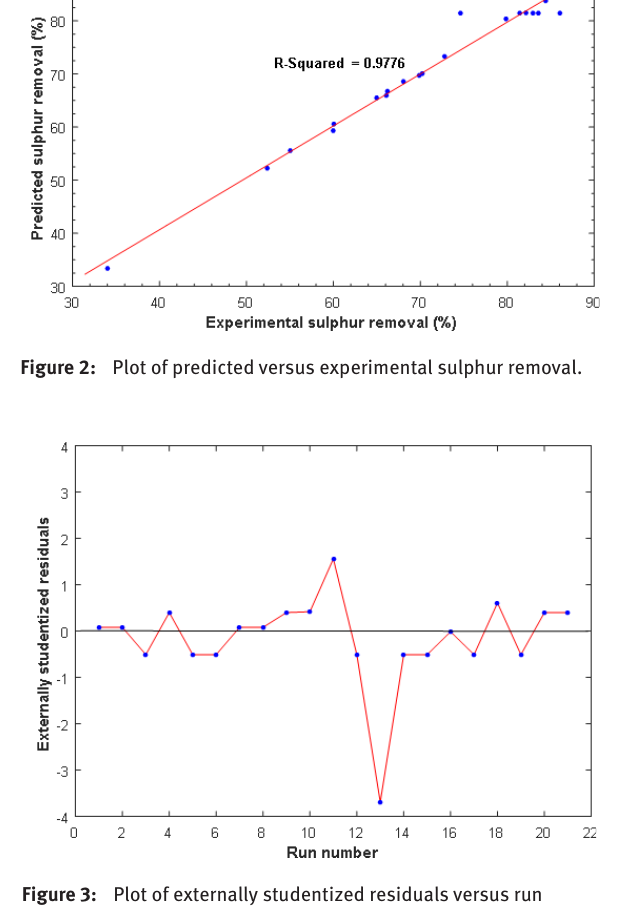
Figure 5: Plot of perturbation of the four parameters.